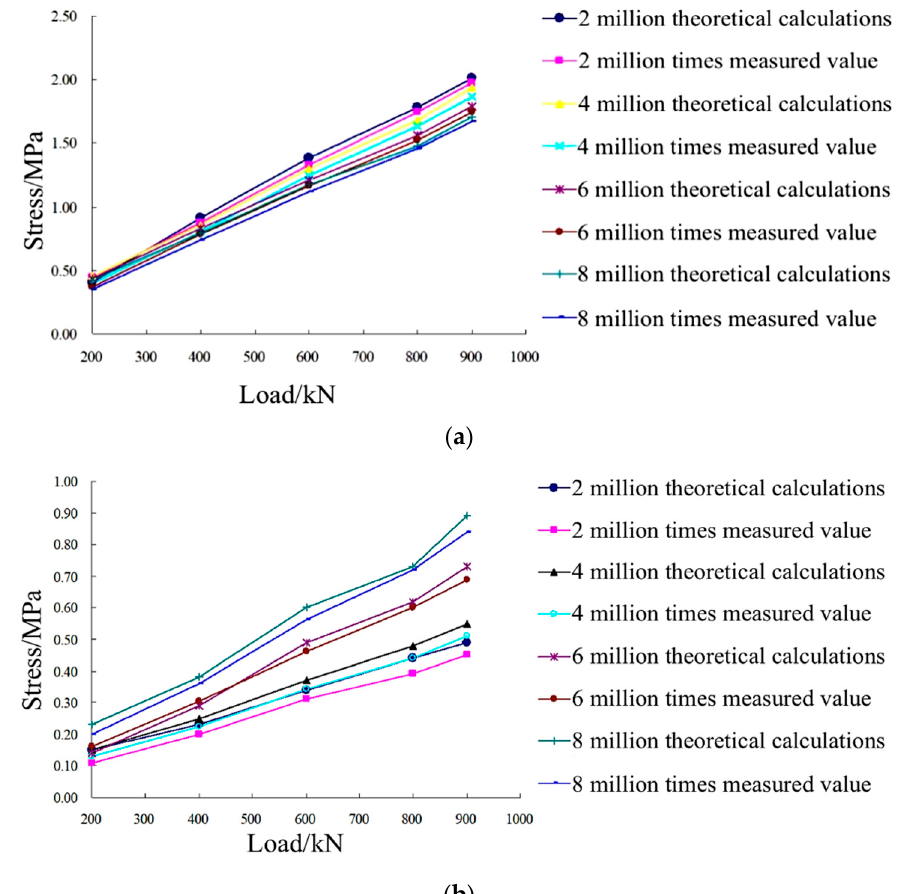
Figure 12. Variation characteristics of structural force and displacement after fatigue loading. ( a ) The vertical displacement of the rail just under the loading point relative to the track slab; ( b ) longitudinal stress of the concrete base just below the loading point.